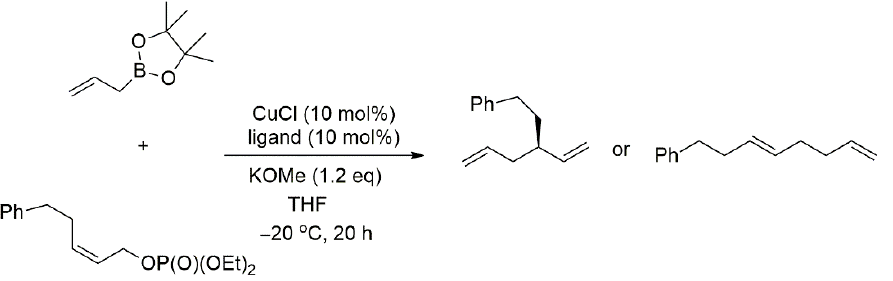
Scheme 37. Reaction of boron pro ‐ nucleophiles with alkynes [81].